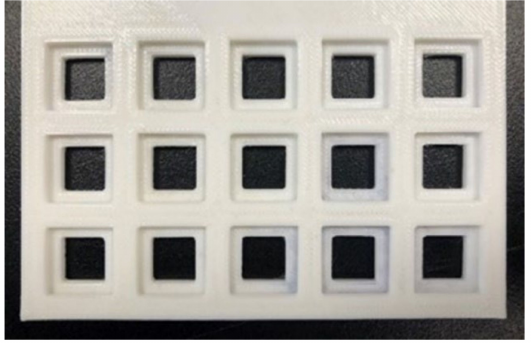
Figure 2. PLA mold to hold the PAD.